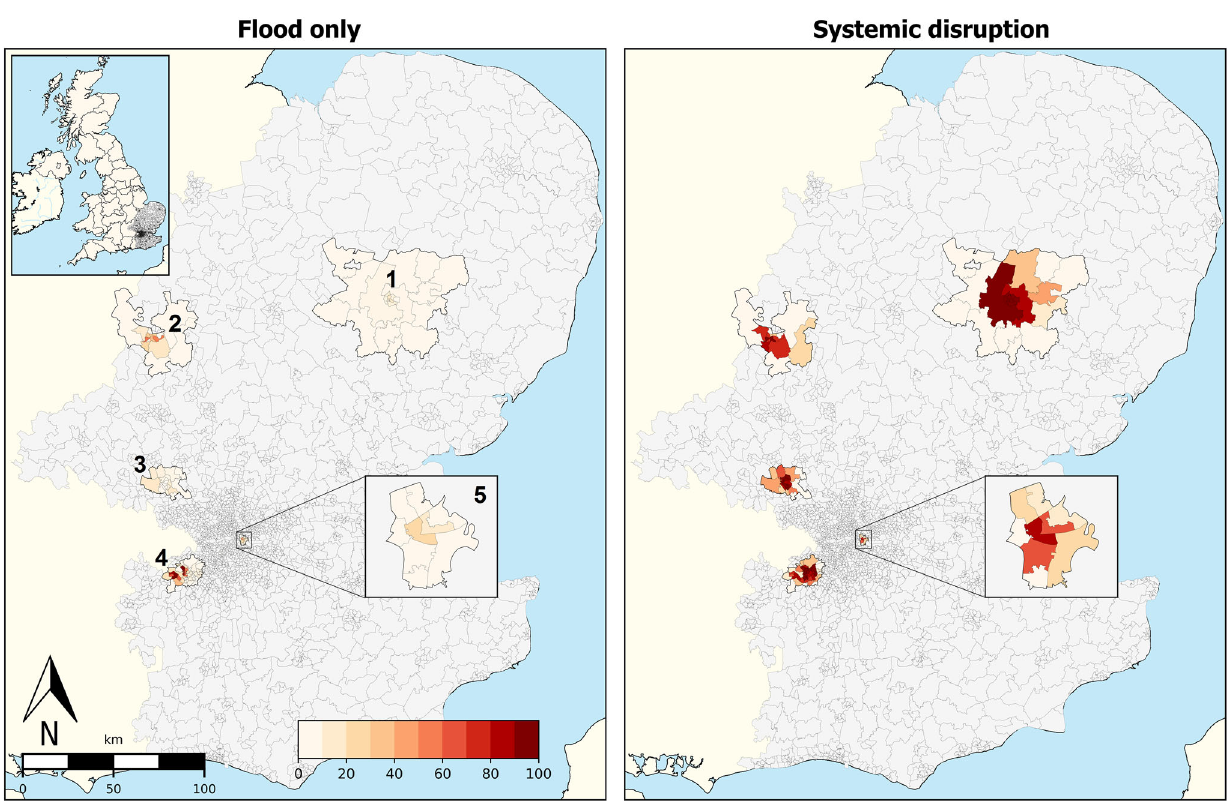
Fig. 5 Presentation of the service areas of the five substations in the southeast of England considered in the failure combinations in Table 3. The left panel shows the percentage reduction of total employment for each MSOA due to flooding only by an event with a